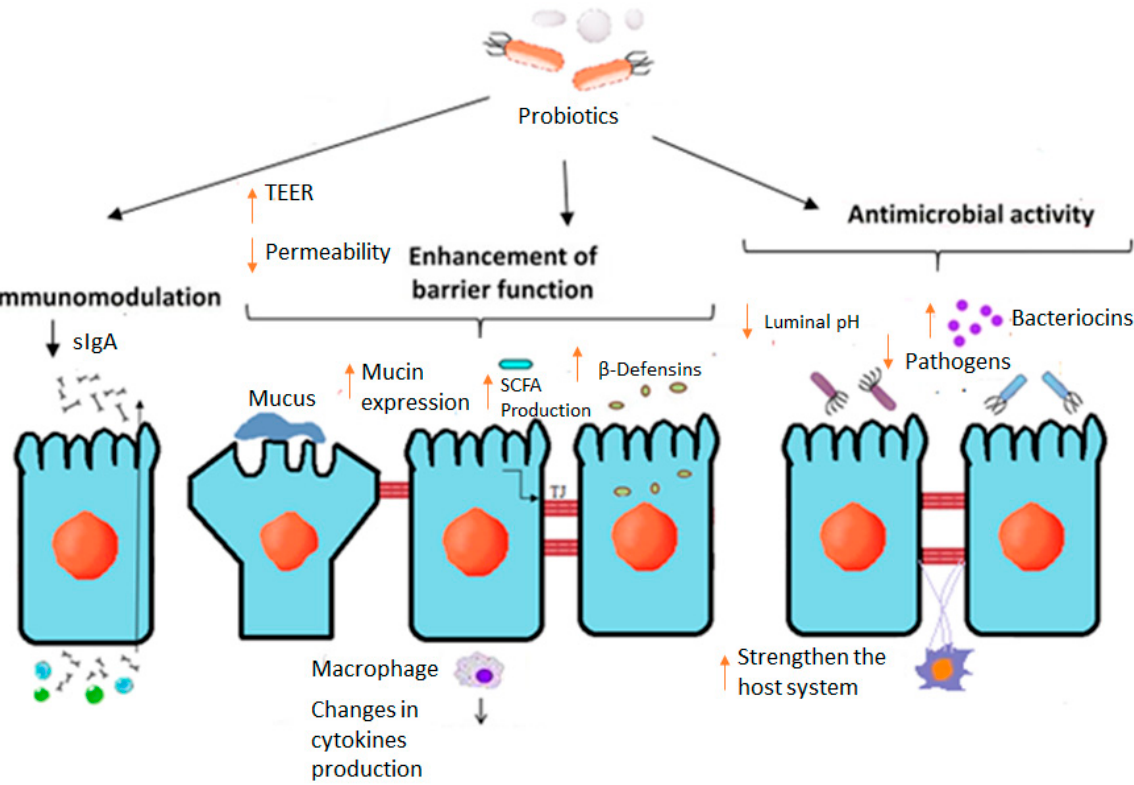
Figure 6. Effects of probiotic bacteria on intestinal epithelial barrier function. Figure adapted from Ohland and MacNaughton (2010) with modifications.